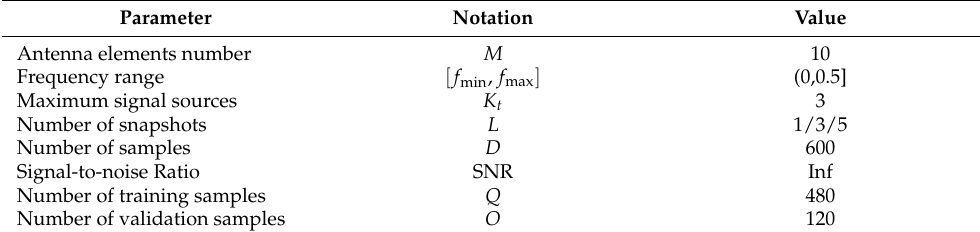
Table 1. Simulation parameters of 1D DOA estimation.